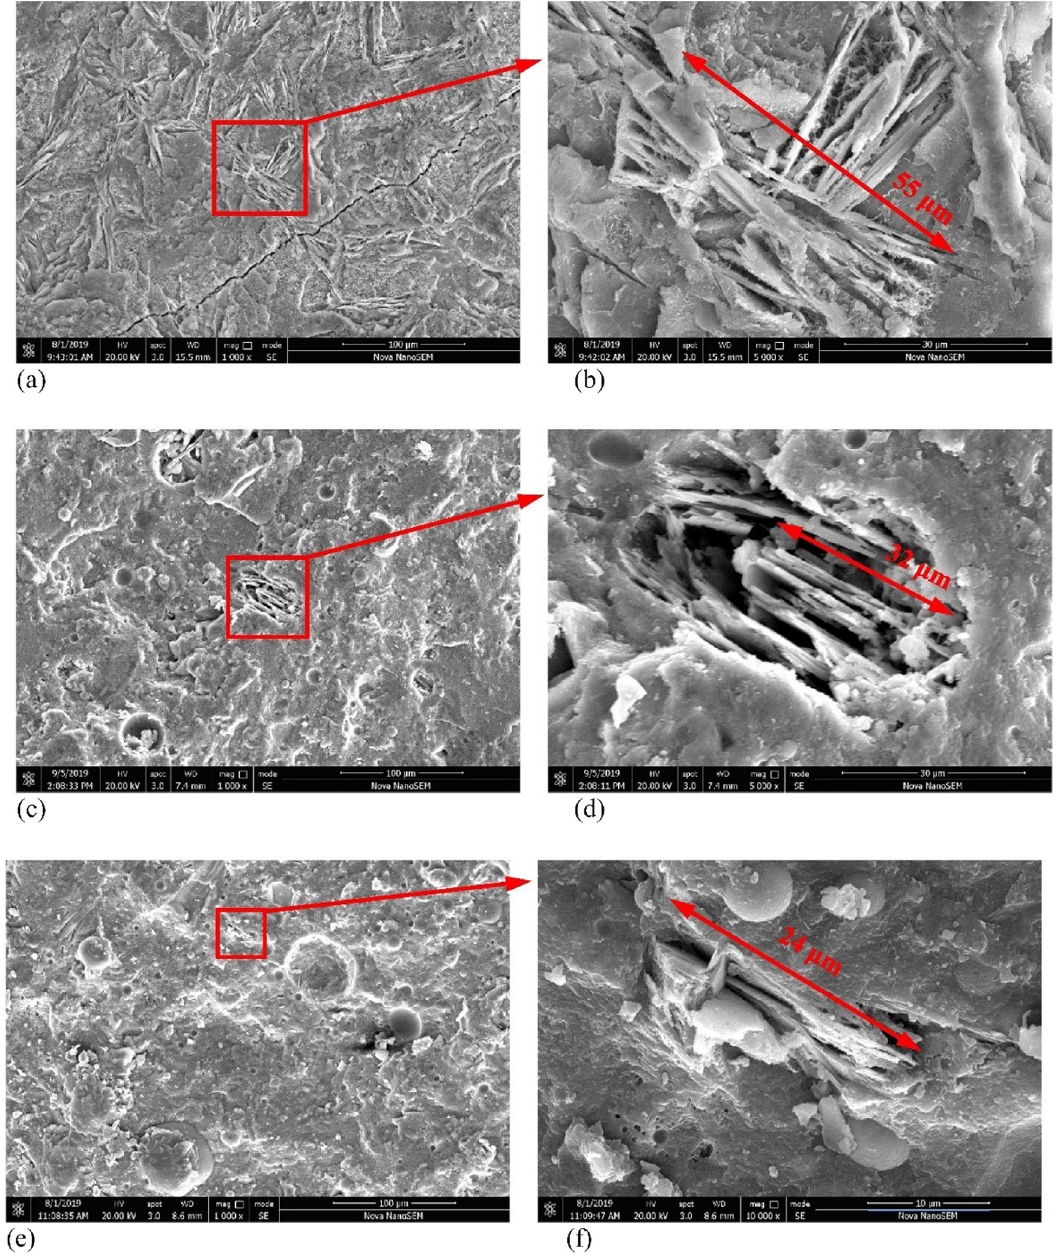
Figure 9: CH crystal size after nanomaterial addition [ 102 ] . ( a ) Cement paste matrix surface microstructure of control specimens ( 1,000 ×) , ( b ) CH crystals in the cement paste matrix surface of control specimens ( 5,000 ×) , ( c ) cement paste matrix surface microstructure of specimens 3 wt% of NS ( 1,000 ×) , ( d ) CH crystals in the cement paste matrix surface of specimens with 3 wt% of NS ( 5,000 ×) , ( e ) cement paste matrix surface microstructure of specimens 2 wt% of NT ( 1,000 ×) , and ( f ) CH crystals in the cement paste matrix surface of specimens with 2 wt% of NS ( 10,000 ×)